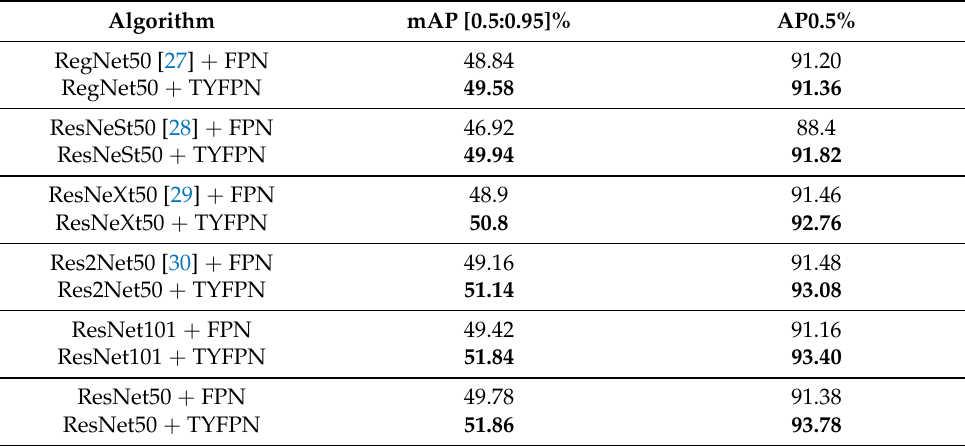
Table 5. Detection results of TYFPN and FPN under different backbone.